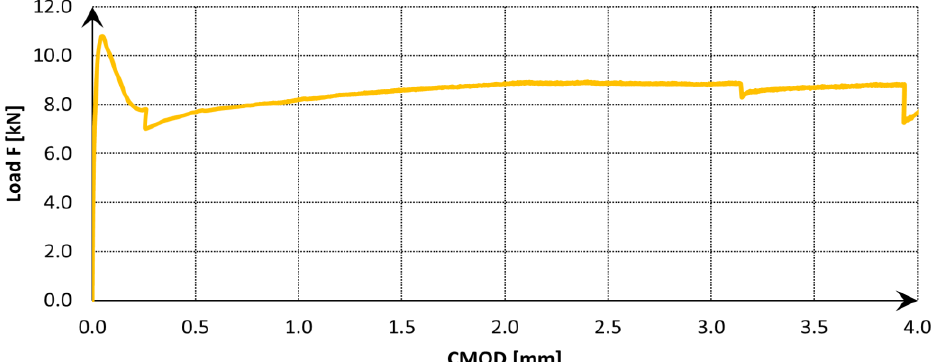
Figure 4. Load-CMOD diagram obtained from the